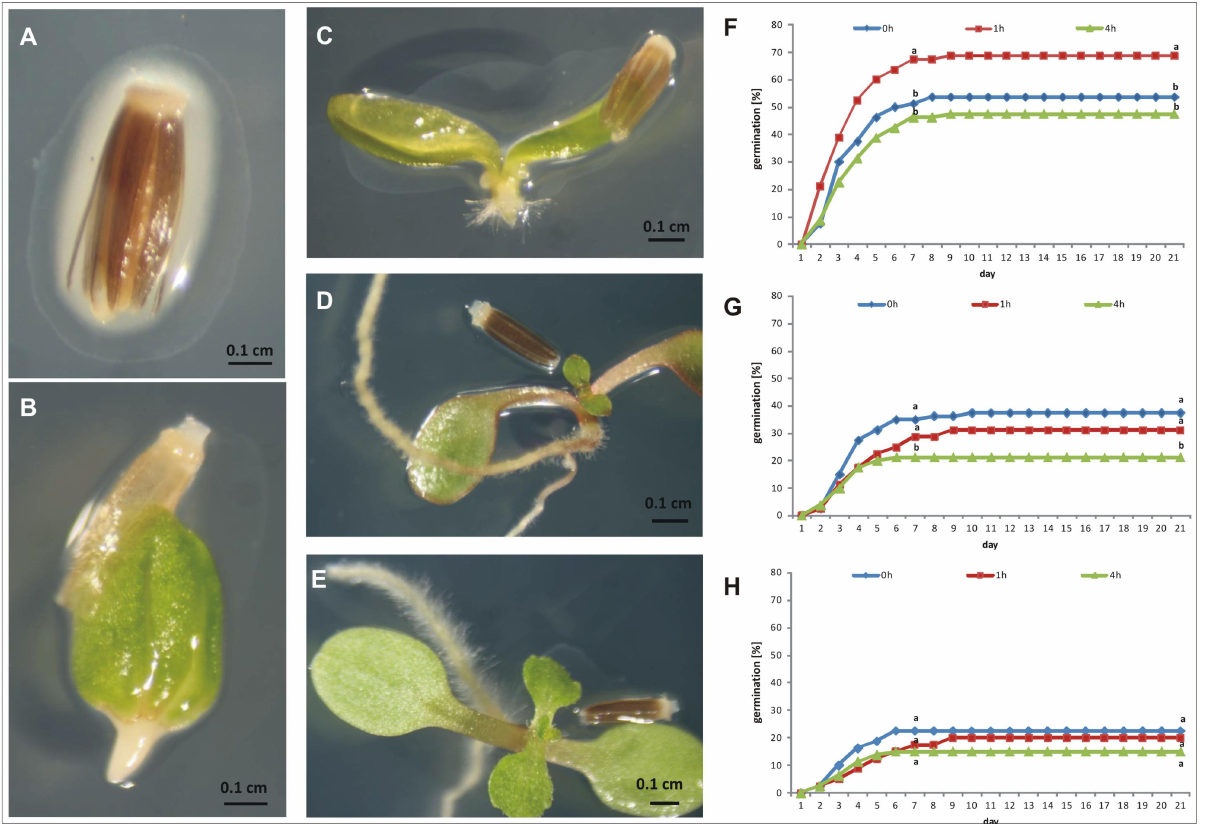
Figure 7. The effect of SRS89 strain on stevia seed germination. Seeds were surface sterilized and inoculated with the isolated Pantoea vagans strain for one or four hours. Non inoculated seeds were used as a control. The following stages of stevia seed germination after inoculation with SRS89 strain ( A – E ). The stevia seed germination on agar gel ( F ), agar gel supplemented with 50 mM NaCl ( G ) or with 150 mM NaCl ( H ). The values of seed germination are means of four replications ( n = 4). Different letters indicate a significant difference in the percentage of germinated seeds at the 7th (germination energy, GE) and 21st (germination capacity, GC) day of incubation at p < 0.05 according to Duncan’s test.